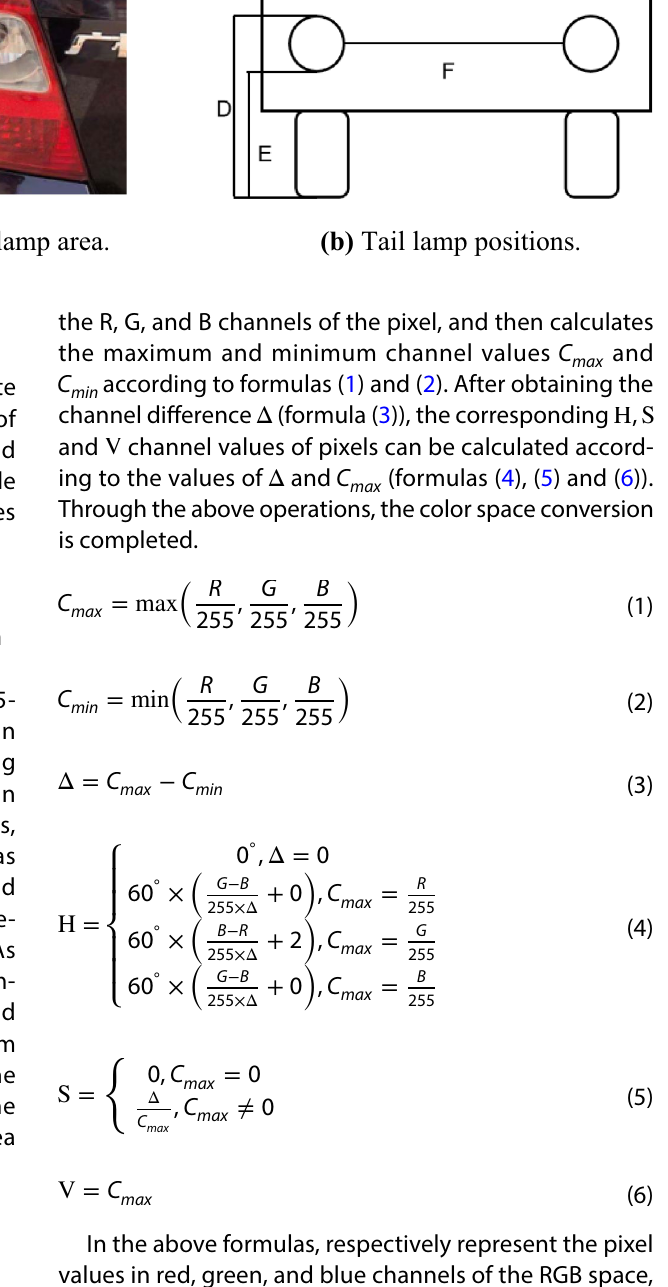
Fig. 4 Schematic diagram of vehicle tail lamp. A Brake lamp in red area, B turn signal lamp in yellow (orange) area, C other tail lamp areas, D the height of the tail lamp top from the ground, E the height of the tail lamp bottom from the ground, F the distance between the tail lamps on both sides